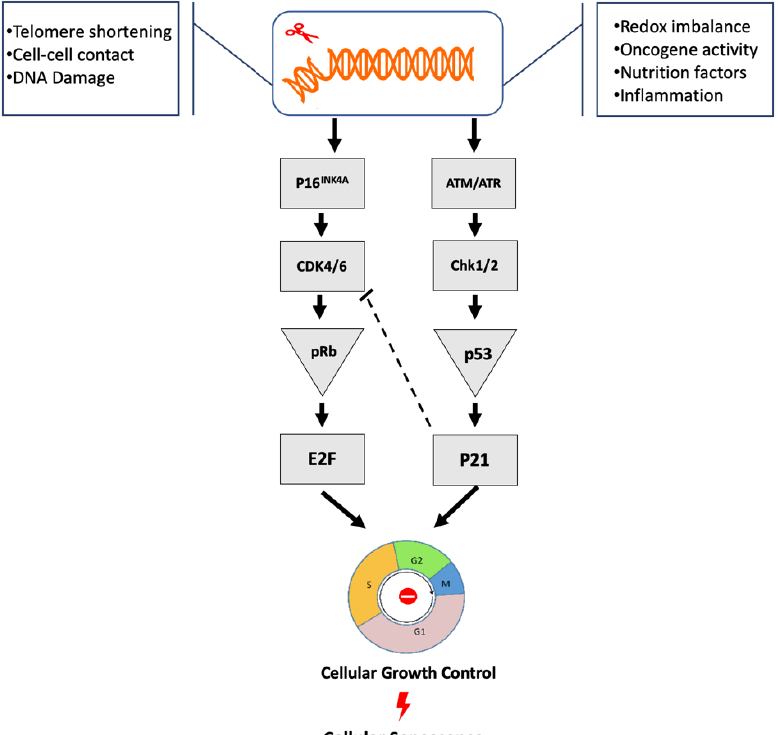
Figure 1. Induction and initiation of cellular growth control and senescence via p53 or P16 INK4A pathways. Various internal or external stress factors trigger the DNA-damage response (DDR) pathway, which in turn activates the p53 and / or the p16 INK4A pathways. p16 INK4A inactivates Cdk4 / 6, results in accumulation of phosphorylated pRb, stops the regulation of E2F transcription factors, and drives cell cycle arrest or senescence. These stressors also trigger DNA damage (cellular responses to such damages are regulated by either ATM-Chk2 or ATR-Chk1 pathways) and transactivate p53 and p21 CIP1 . Moreover, p21 CIP1 protein levels may lead to the inhibition of Cdk4 / 6 activity, which contribute to the G1 arrest or senescence [33,34].